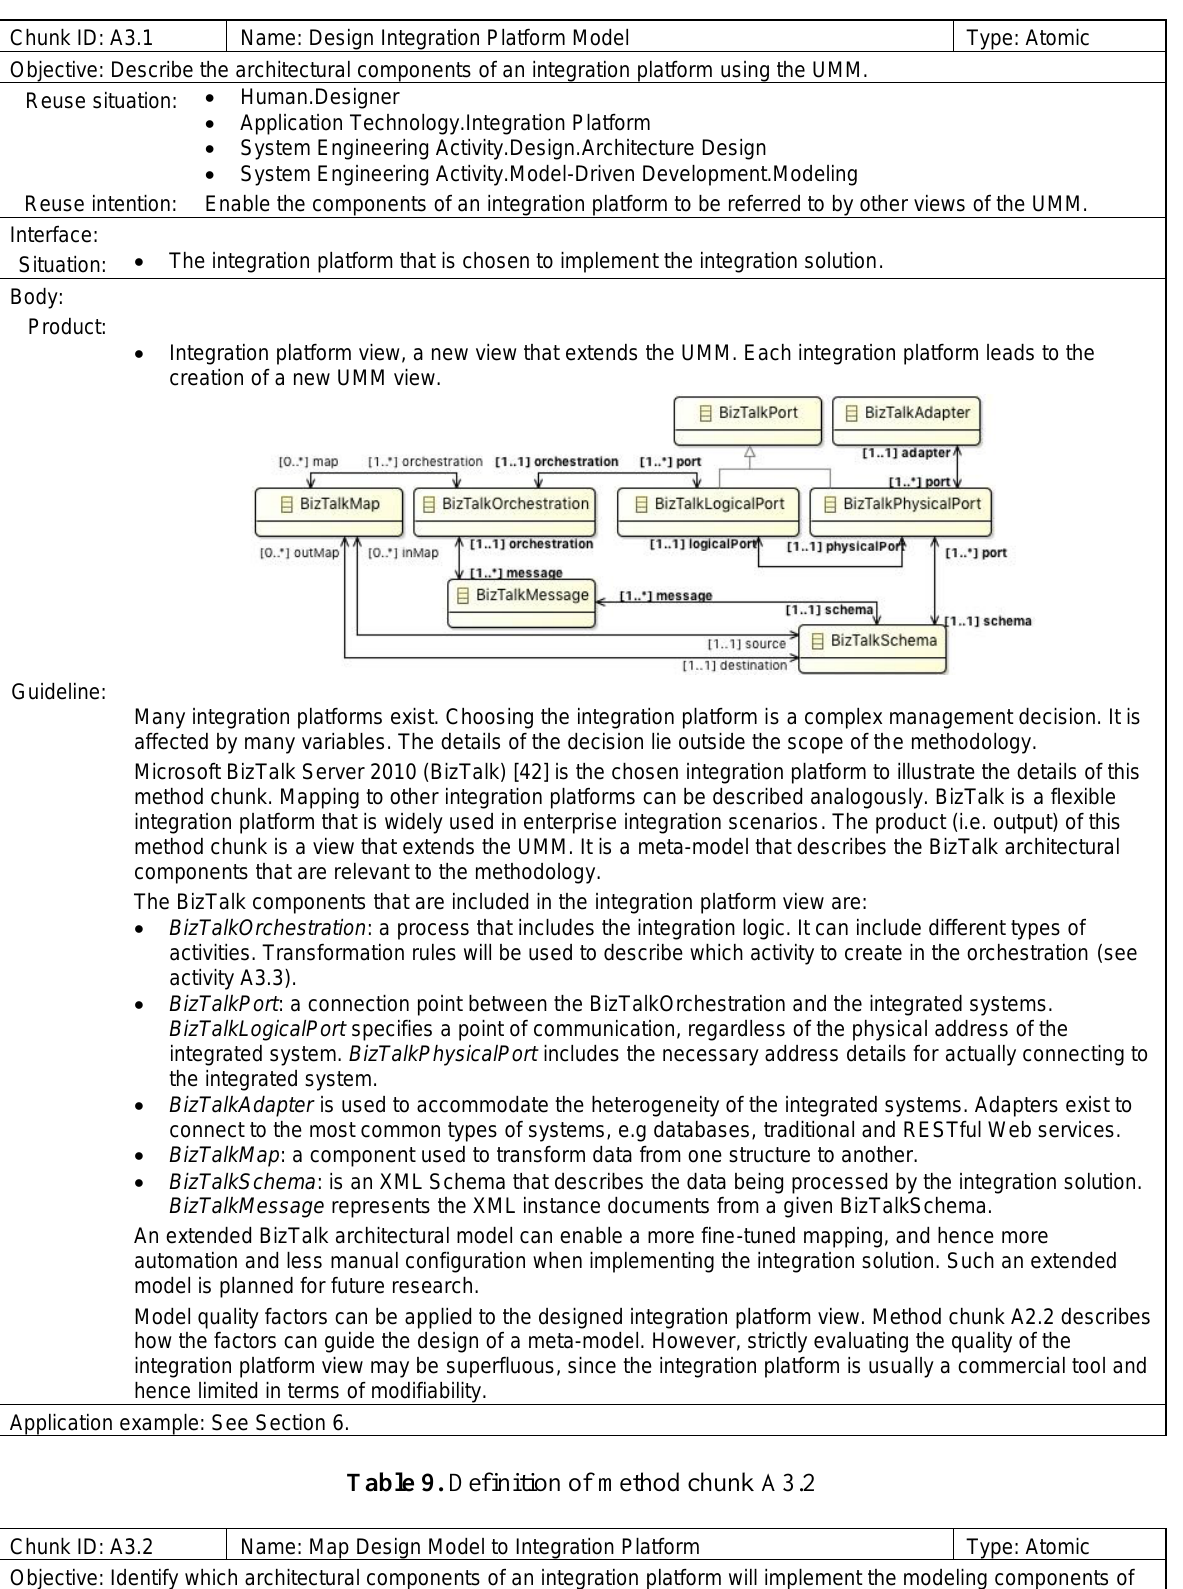
Table 8. Definition of method chunk A3.1